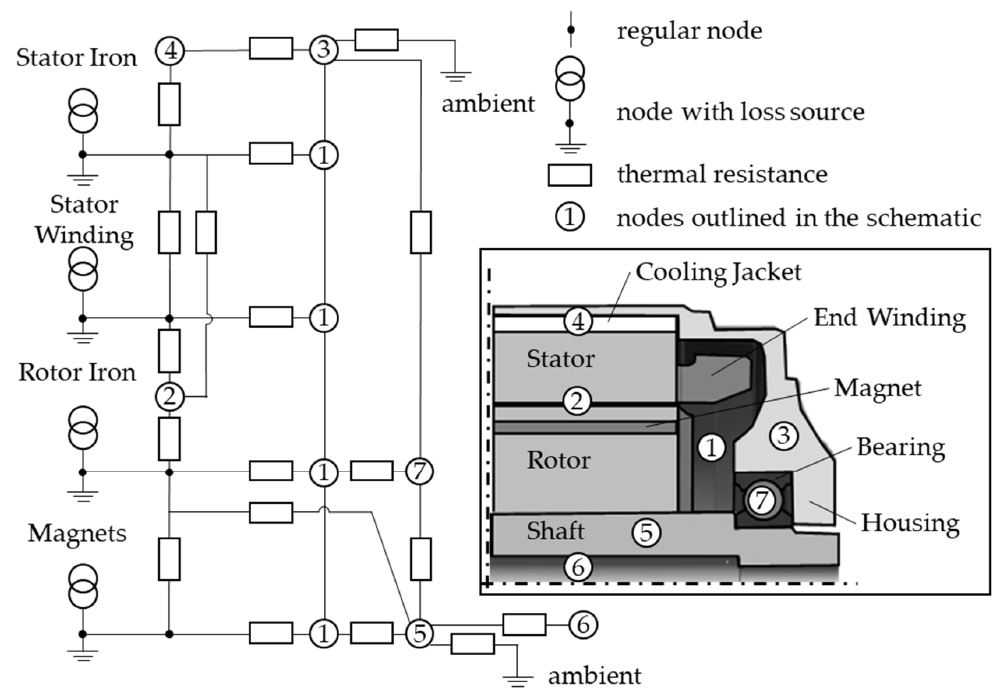
Figure 4. Simplified lumped parameter thermal model with resistances between the active compo- nents and the cooling medium for a PMSM.